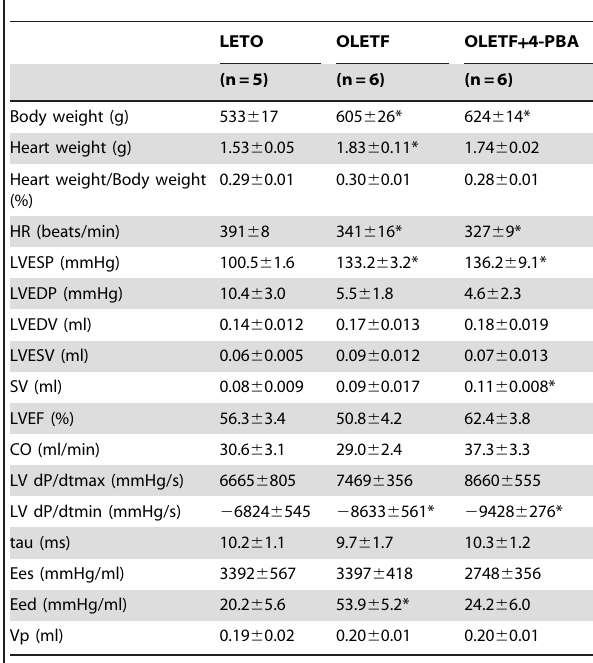
Table 2. Summary data from pressure-volume relationships.